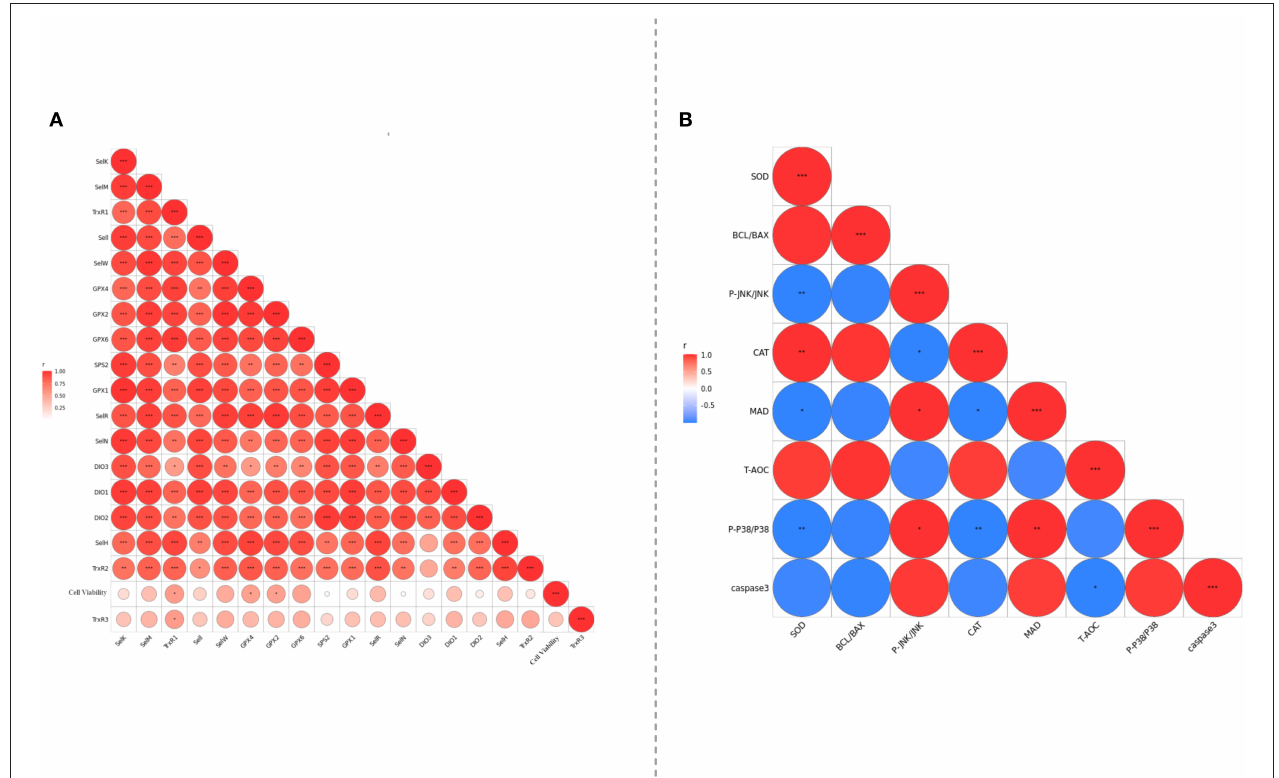
FIGURE 8 | (A) Analyzed the correlation between selenoprotein mRNA expression levels of PMCES cultured with different additives and different dosage. (B) The degree of correlation between PMCEs related indicators of antioxidant and apoptosis was analyzed. The area size and color of the circle in the figure represent the correlation, *0.01 < P < 0.05; **0.001 < P ≤ 0.01; *** P ≤